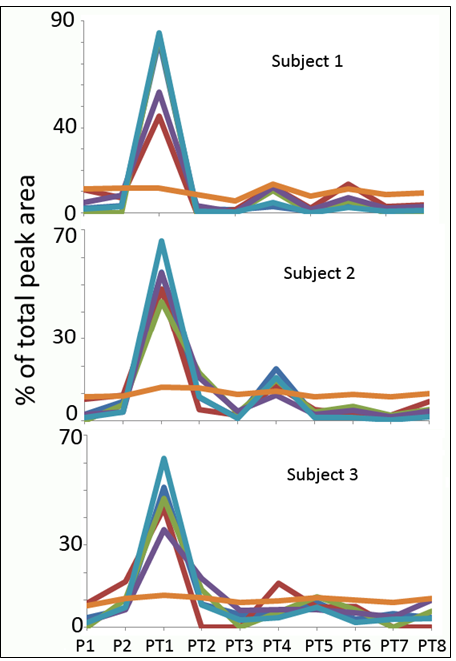
Figure 4. Comparison of the exercise response of the area percentage for MS creatinine (orange) with the levels of some metabolites from the purine pathway, hypoxanthine (light blue), xanthosine (green), inosine (red) and guanine